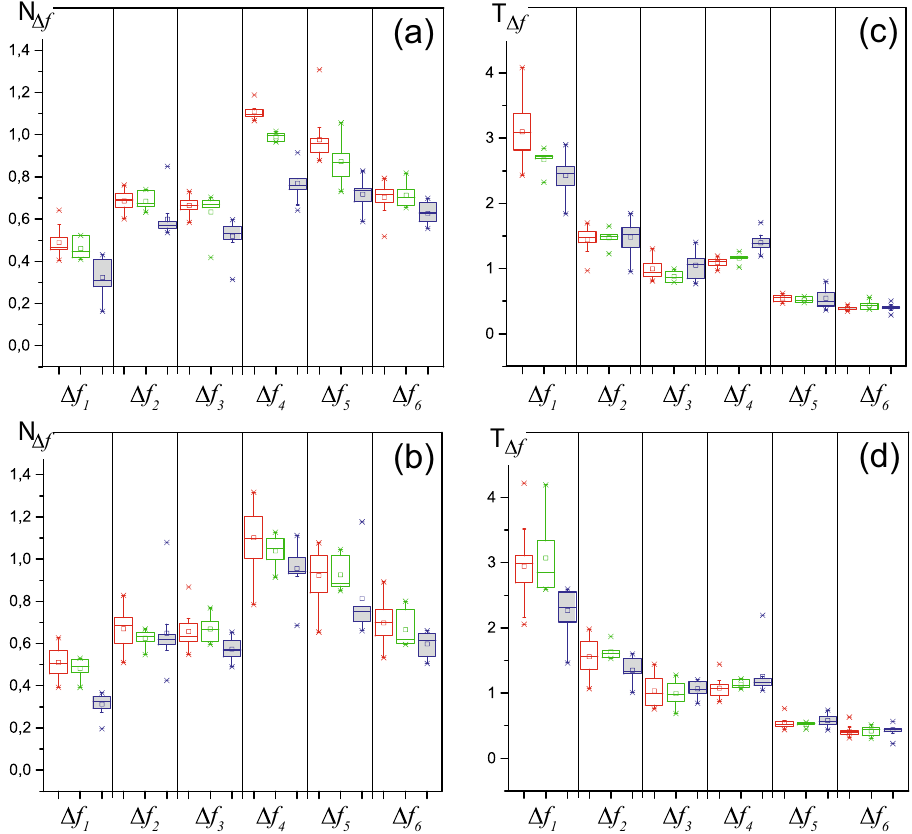
Figure 3. The diagrams present range of normalized number N (cid:31) f and duration T (cid:31) f of the oscillatory patterns for six selected frequency ranges for animal #3: ( a , b ) are the pattern’s normalized N (cid:31) f (??) for wakefulness and sleep periods, respectively, ( c, d ) are the pattern’s normalized durations T (cid:31) f (??) for similar animals states. For each frequency band (cid:31) ( f ), the results are obtained for the records ECoG1 (the first diagram in each band, highlighted in red), ECoG3 (the second diagram in each band, highlighted in green), ECoG2 (the third diagram in each band, highlighted in blue) . The horizontal line shows the median value, the square—the arithmetic mean, and the crosses “x”—single outliers on each